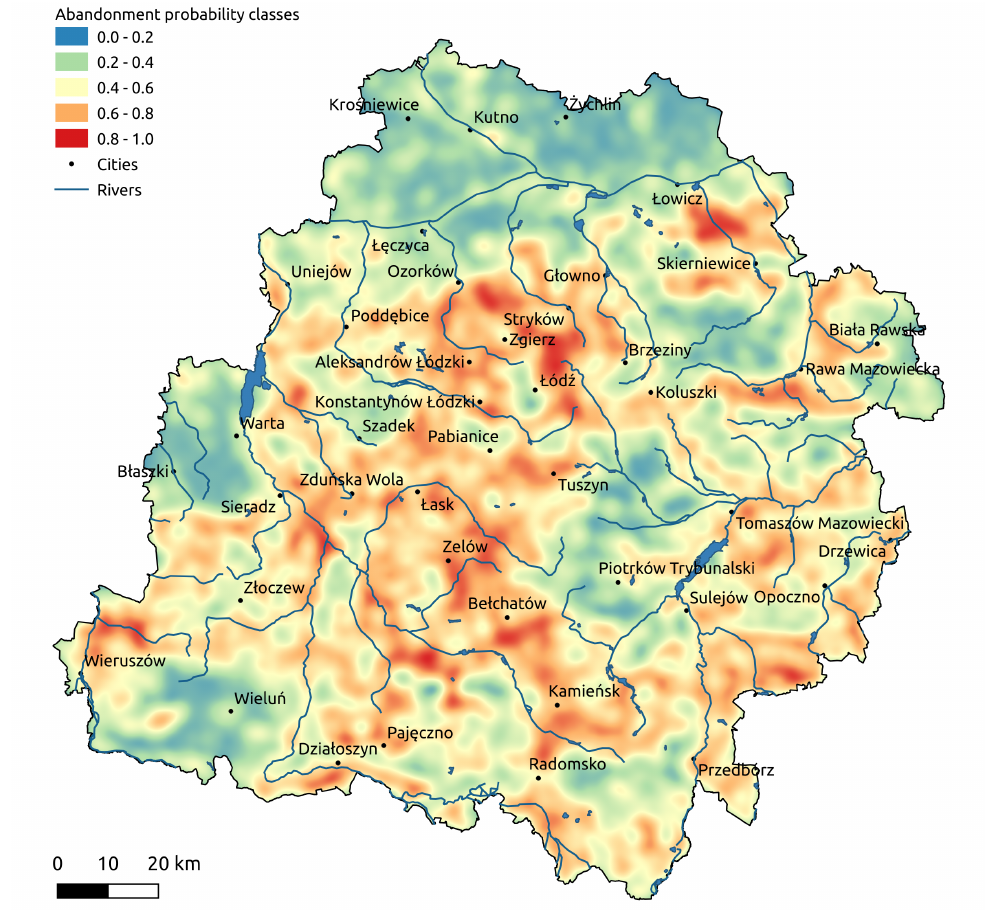
Figure 7. Probability distribution map of land abandonment across the Łód´z